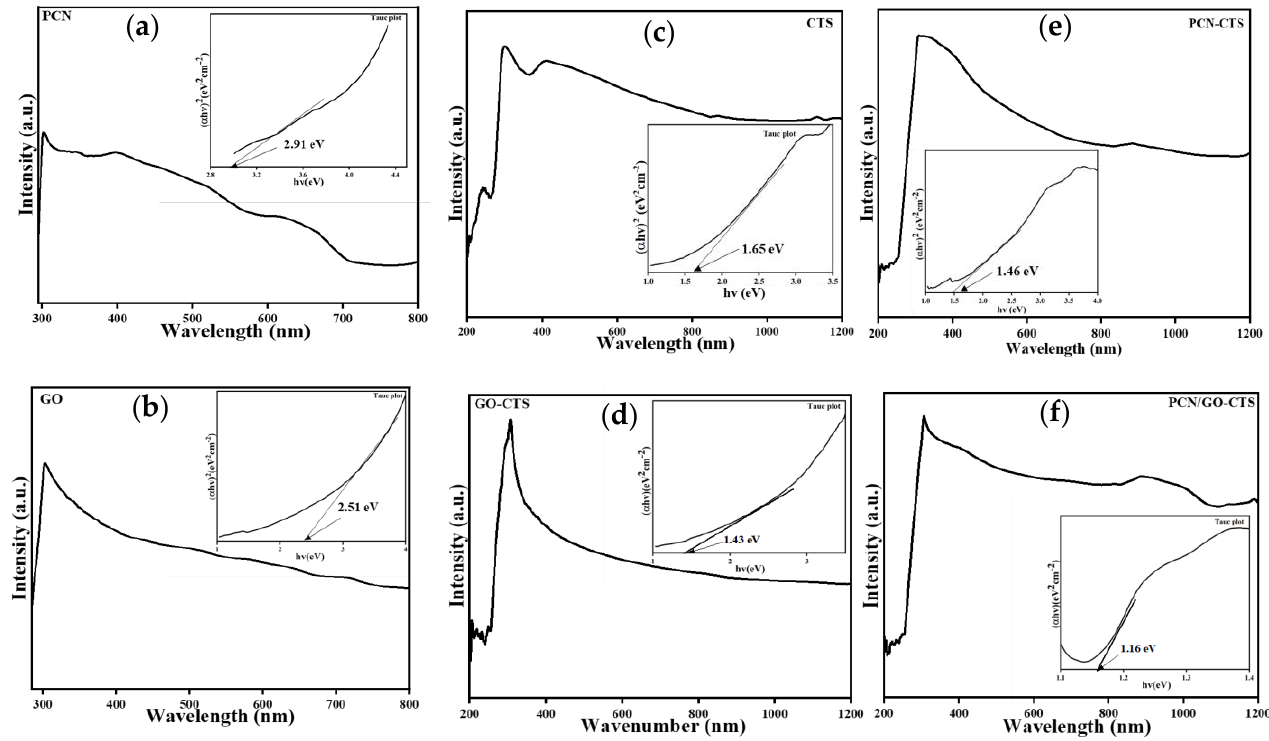
Figure 4. Absorption spectra of ( a ) PCN, ( b ) GO, ( c ) CTS, ( d ) GO-CTS, ( e ) PCN-CTS, and ( f ) PCN/GO-CTS and their respective Tauc plots (inset).